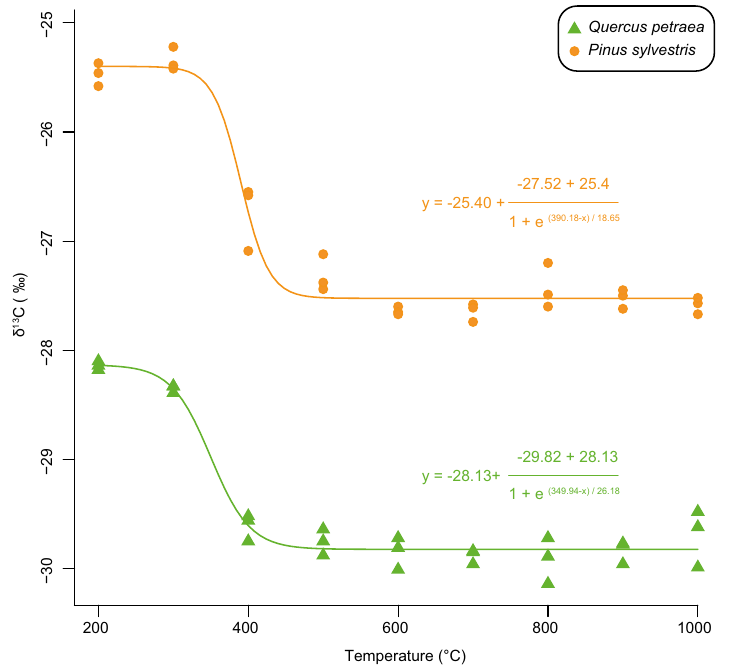
Figure 4. Modifications of δ 13 C char values with carbonisation temperatures in charred oak and pine charred